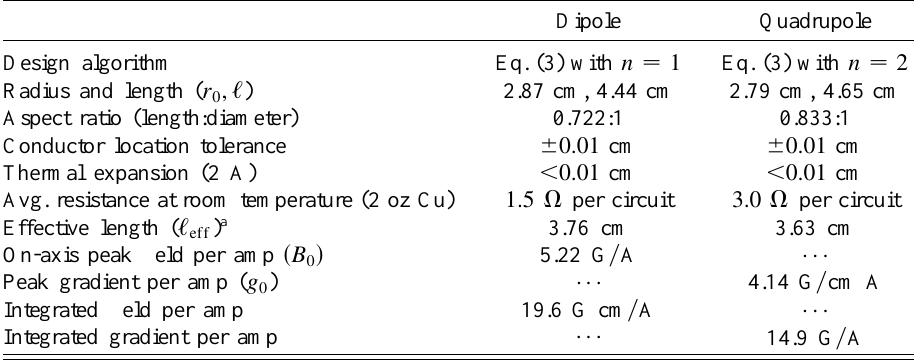
Dipole Quadrupole